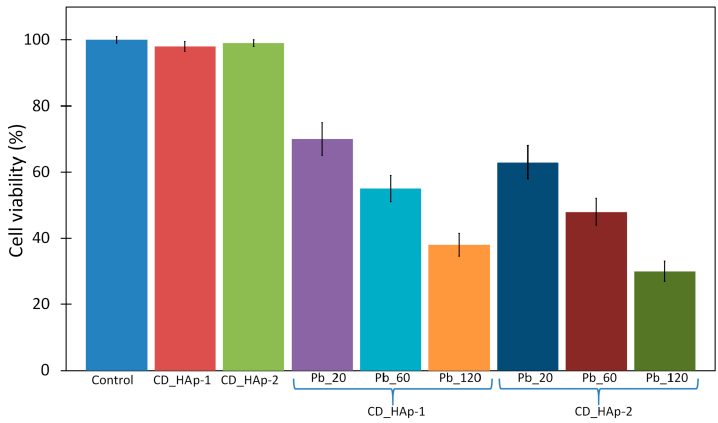
Figure 14. Cell viability assay in HeLa cells for CD-HAp_1 and CD-HAp_2 before and after the adsorption of lead ions (20, 60 and 120 mg/L) for 24 h of incubation at 37 °C. Each value represents the mean value ± SD (*** p < 0.001, n = 4).